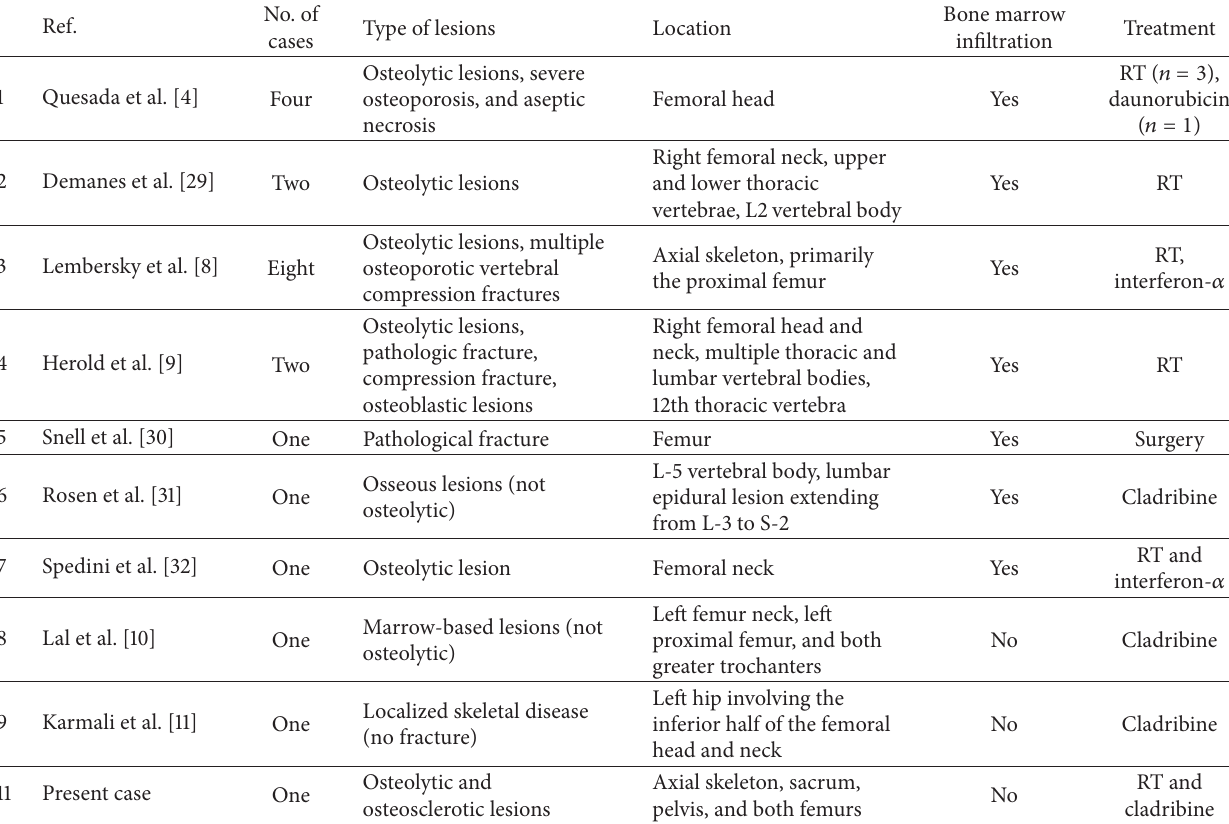
Table 1: Clinical features of reported cases of HCL with skeletal